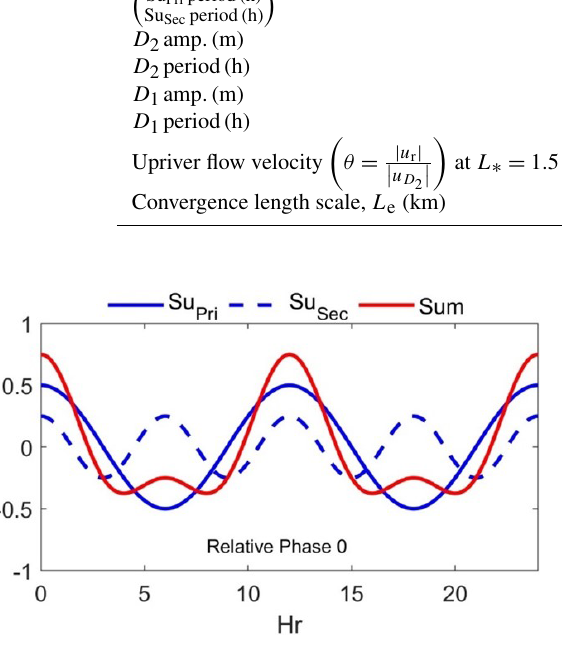
Figure 6. A symmetric surge wave that is the result of two sinu- soidal waves (i.e., surge = Su Pri + Su Sec